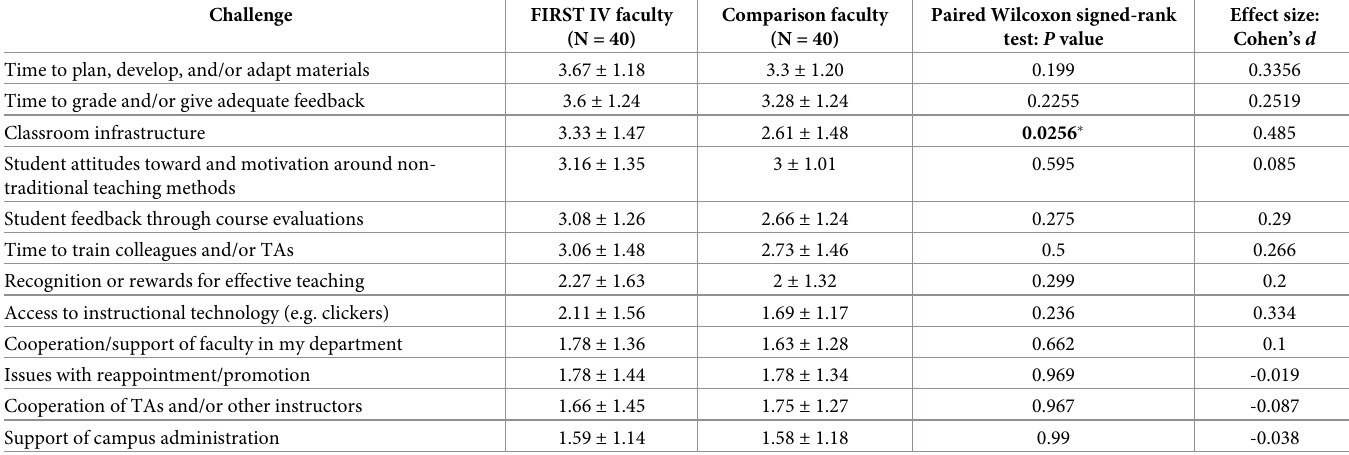
Table 1. The degree to which the following poses a challenge to implementing active learning in a course (1 = Not a challenge, 5 = Highly challenging). Reported val- ues for faculty are the mean and standard deviation within a group. Obstacles are sorted by most challenging for FIRST IV faculty, from high to low. Data originate from the background survey (S1 File).